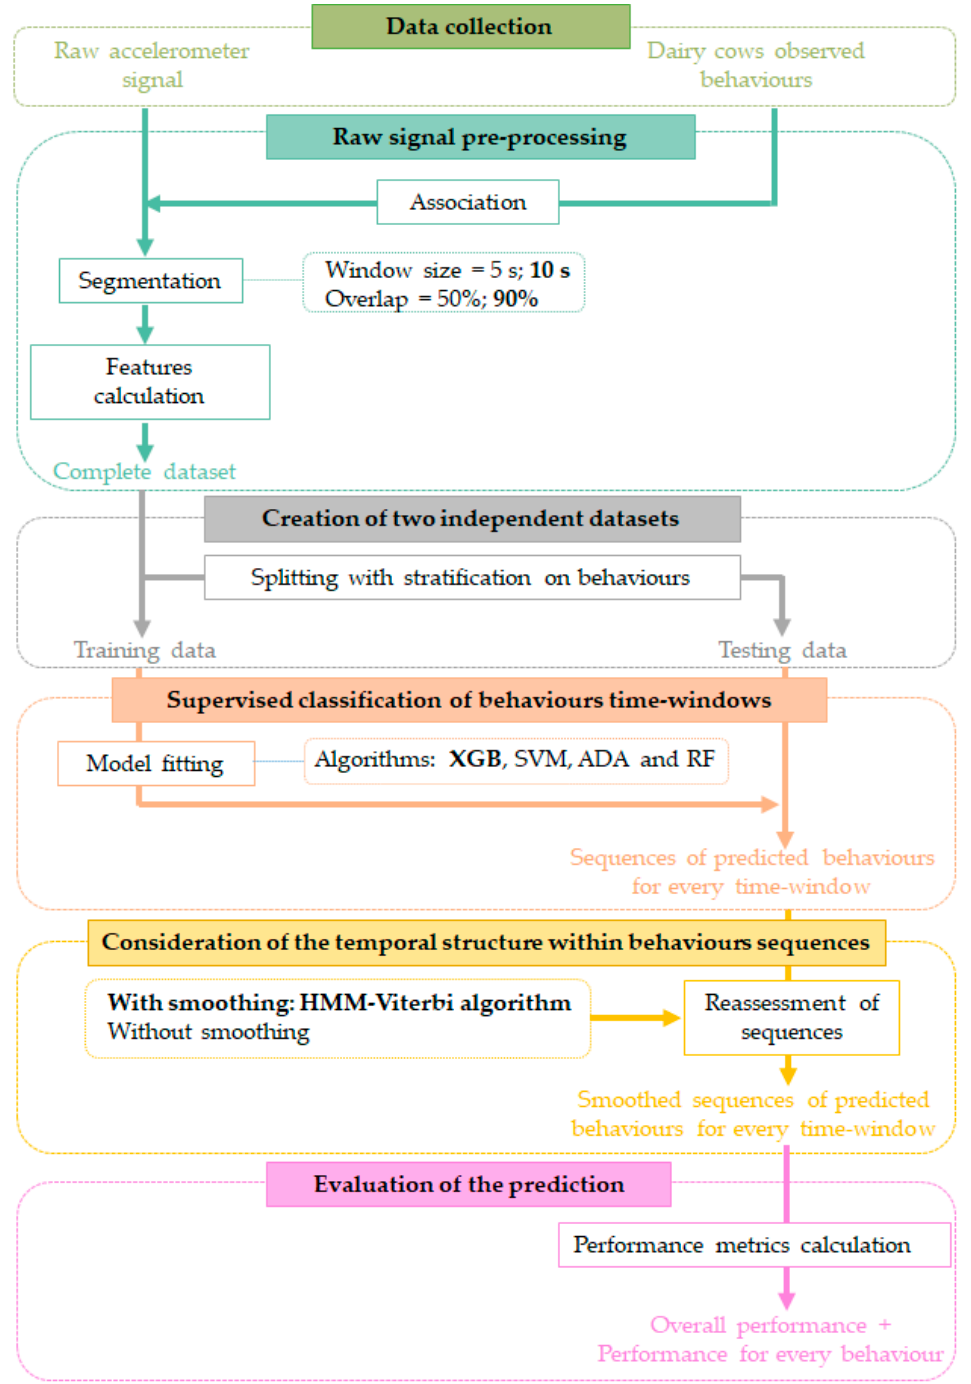
Figure A1. Method carried out in the previous studies to develop an appropriate methodology to predict the range of the main behaviors of dairy cows at pasture. Note: The techniques leading to the best performance (accuracy—98%; Cohen’s Kappa—0.96) are written in bold. The combination of the best techniques corresponds to the methodological framework used in the present study.